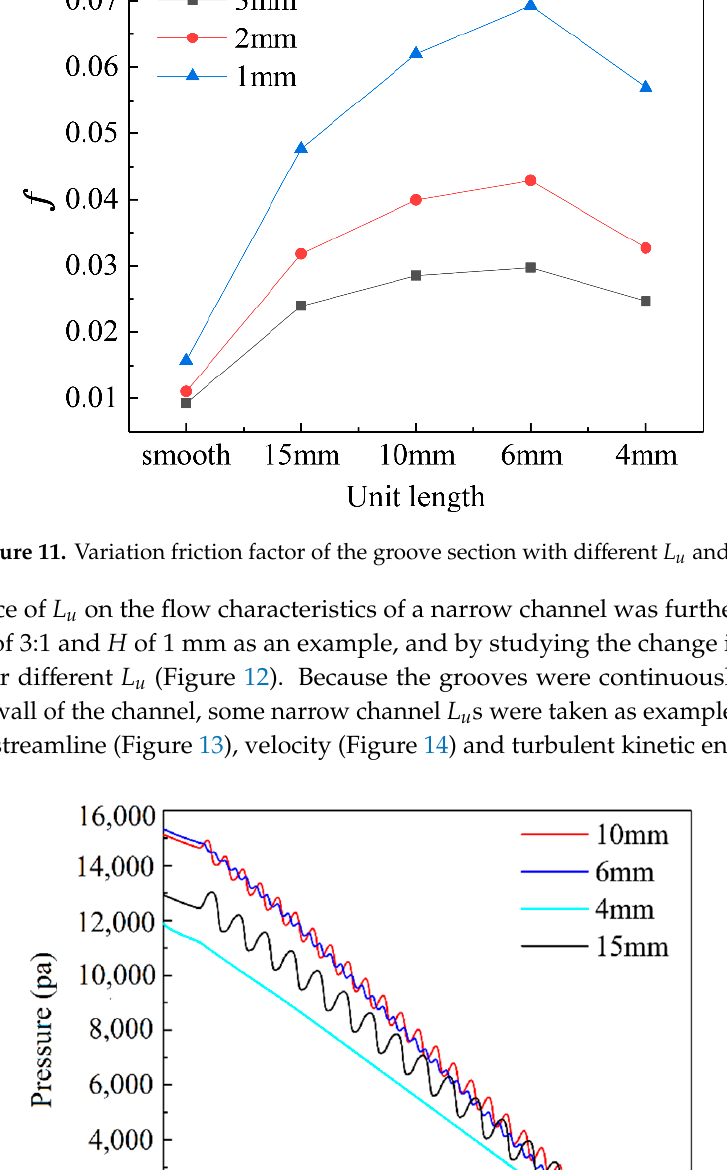
L (Re = 3750). Figure 12. Curves of pressure variation along the system under di ff erent L u (Re = u